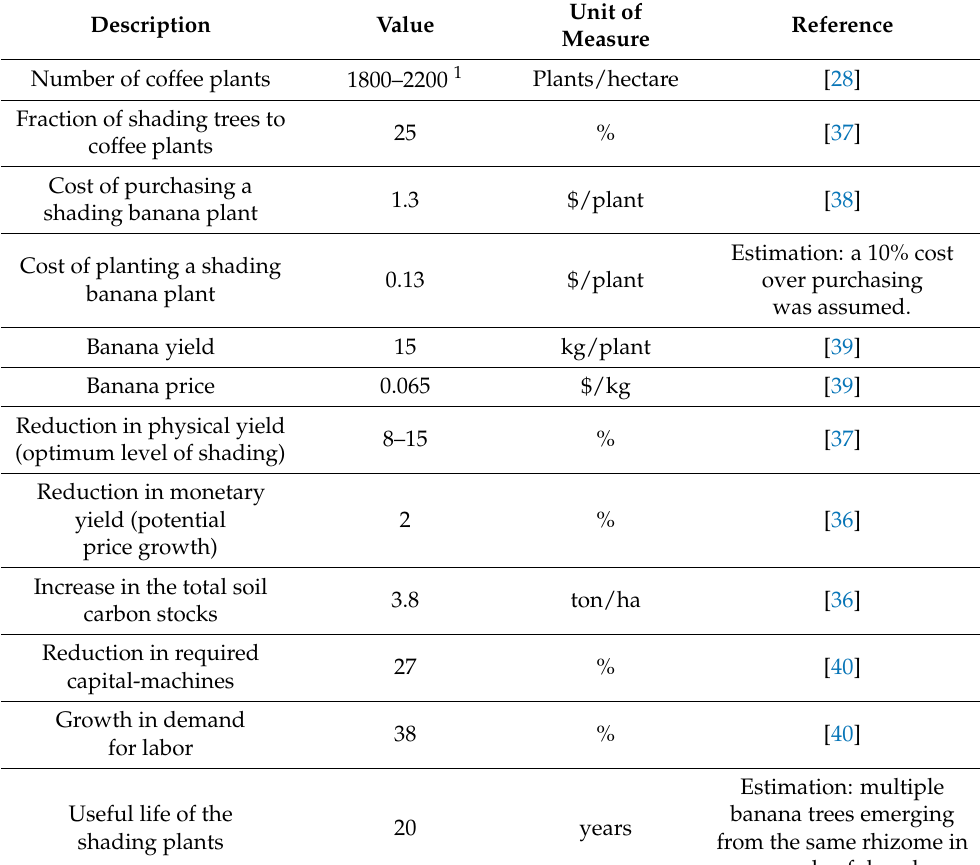
Table 1. Input parameters for shading tree management